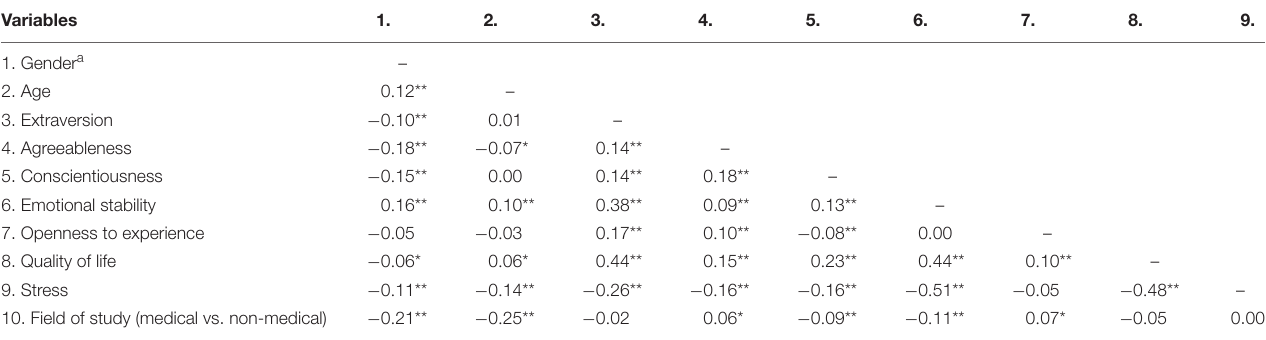
TABLE 2 | Correlation coefficients (Point-Biserial, Pearson product-moment) between study variables.